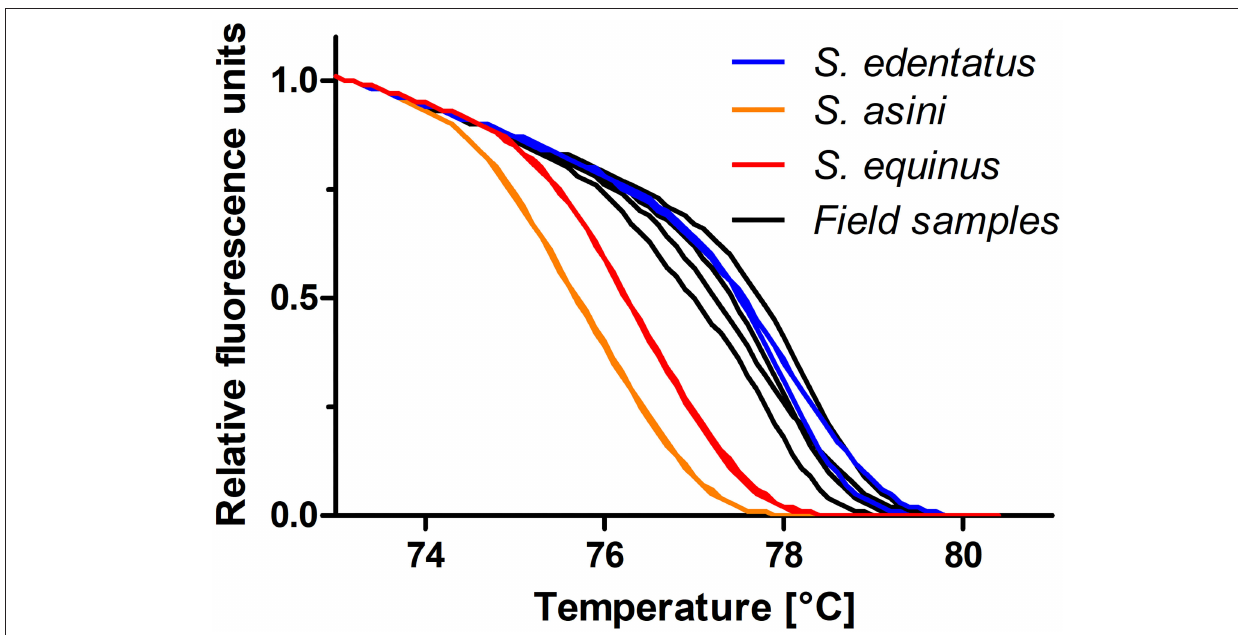
FIGURE 4 | High-resolution melting curves for DNA from four field samples compared to standards containing 500 copies of the ITS-2 of S. edentatus , S. equinus, and S. asini . All positive samples were assigned to S. edentatus , which was confirmed by Sanger sequencing of the PCR products.